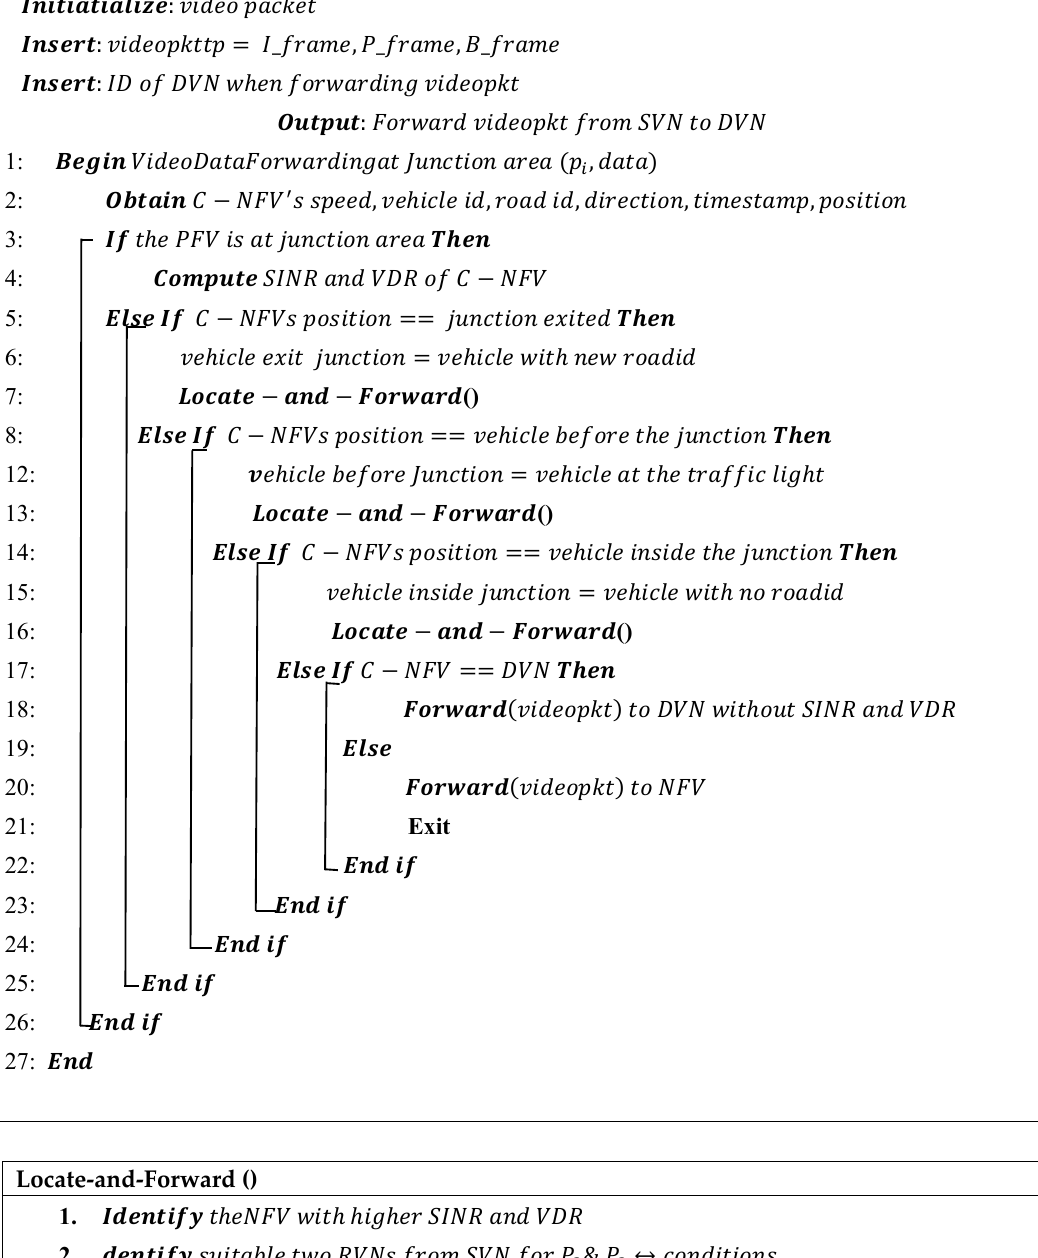
Algorithm 1. Junction-Aware Multipath Video Forwarding.